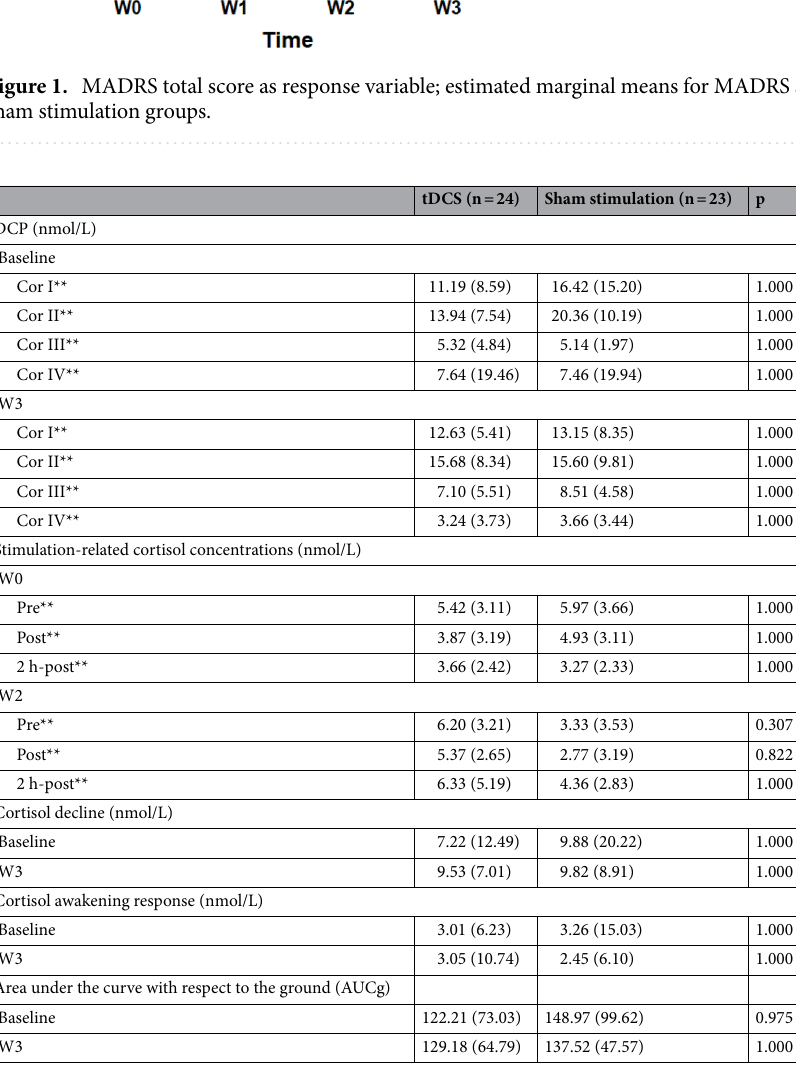
Table 3. Characteristics of the participants’ experimental concentrations of cortisol. Values are expressed as mean (standard deviation). Pre, immediately before stimulation; post, immediately after stimulation; 2 h-post, 2 h after stimulation; Cor I, between 7:30 and 8:00 AM; Cor II, between 8:00 and 8:30 AM; Cor III, between 3:30 and 4:00 PM; Cor IV, between 9:30 and 10:00 PM. *Of the 47 patients included in the study, 40 completed the three-week treatment, and seven dropped out of the study before finishing the trial. Hence, data of 4 participants of the sham stimulation group and 3 of the tDCS are missing. **p-values are Bonferroni-